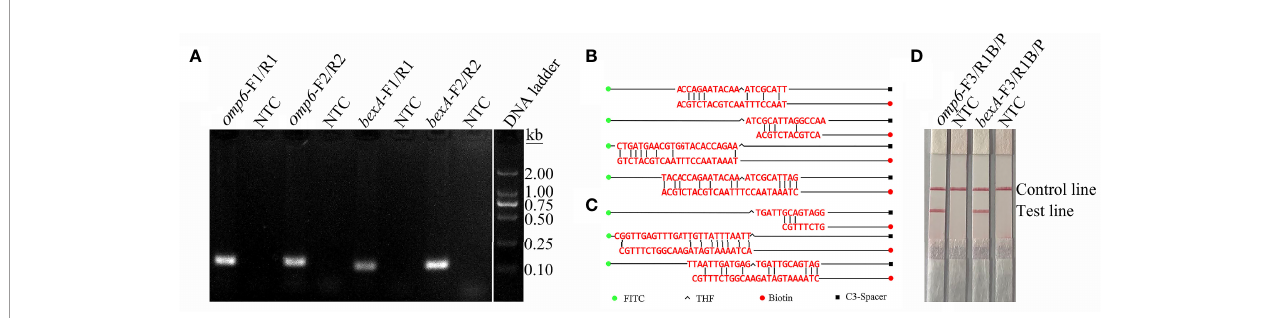
FIGURE 1 | Screening of primers and probes. (A) RPA was performed to screen the primers. Agarose gel images showing the ampli fi cation results of primer pairs targeting the two virulence genes omp6 and bexA . The primer pair is indicated at the top of each lane. NTC, no template control. The band sizes of the DNA ladder are shown on the right. The images represent the results of three independent experiments. (B) A dimer formed between probe-reverse primer and probe-probe based on the omp6 gene design. (C) Dimers formed between the probe-reverse primer and probe-probe based on the bexA gene design. (D) Testing of the modi fi ed primer – probe set. The image shows the LFS results of RPA ampli fi cations. The name of each primer-probe set is indicated at the top of the corresponding strip. The template consisted of 1 µL of boiled non-capsulated or capsulated H. in fl uenzae culture at 10 6 CFU/mL. NTC, no template control. The positions of the test and control lines are marked on the right of the strip image. The reactions were performed for 30 min at 37°C. The image represents the results of three independent